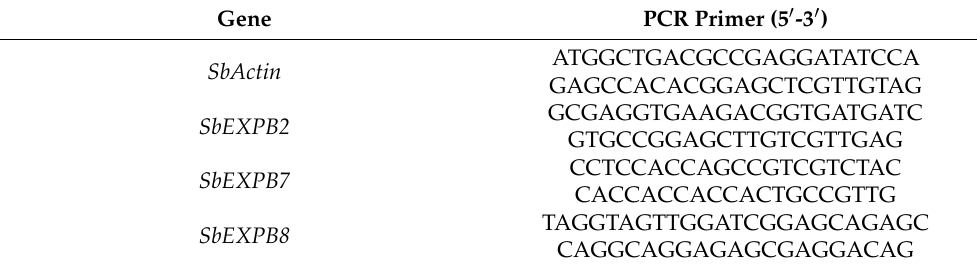
Table 1. The primers for qPCR experiment.